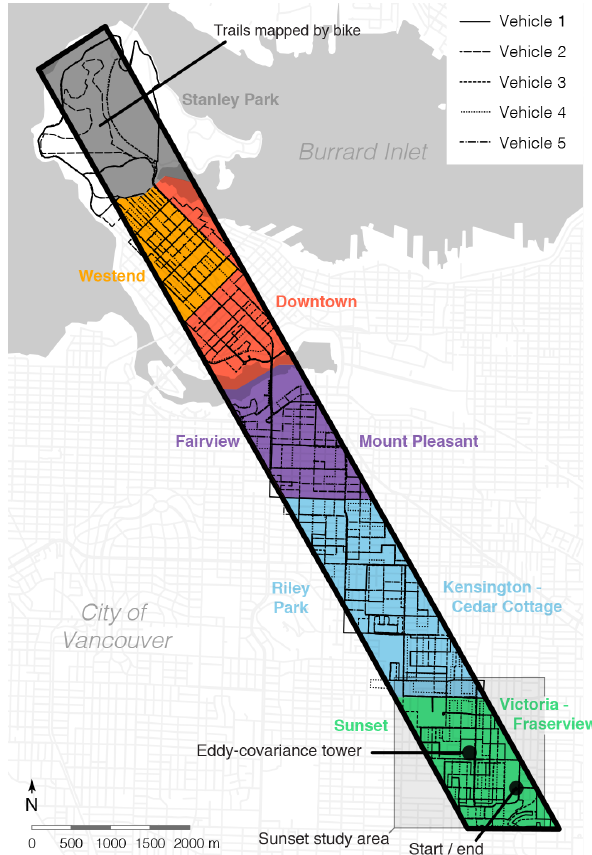
Figure 2. Map of the study area (thick black outline). Thin black lines refer to the paths of each of the five DIYSCO 2 systems. The coloured areas are the neighbourhoods used in further analysis. The location of the eddy-covariance tower and the start and end point of all paths are labelled. The 1.9 × 1.9 km box labelled “Sunset study area” refers to the domain of previous research, including the fine- scale emission inventory developed by Christen et al. (2011) and Kellett et al.